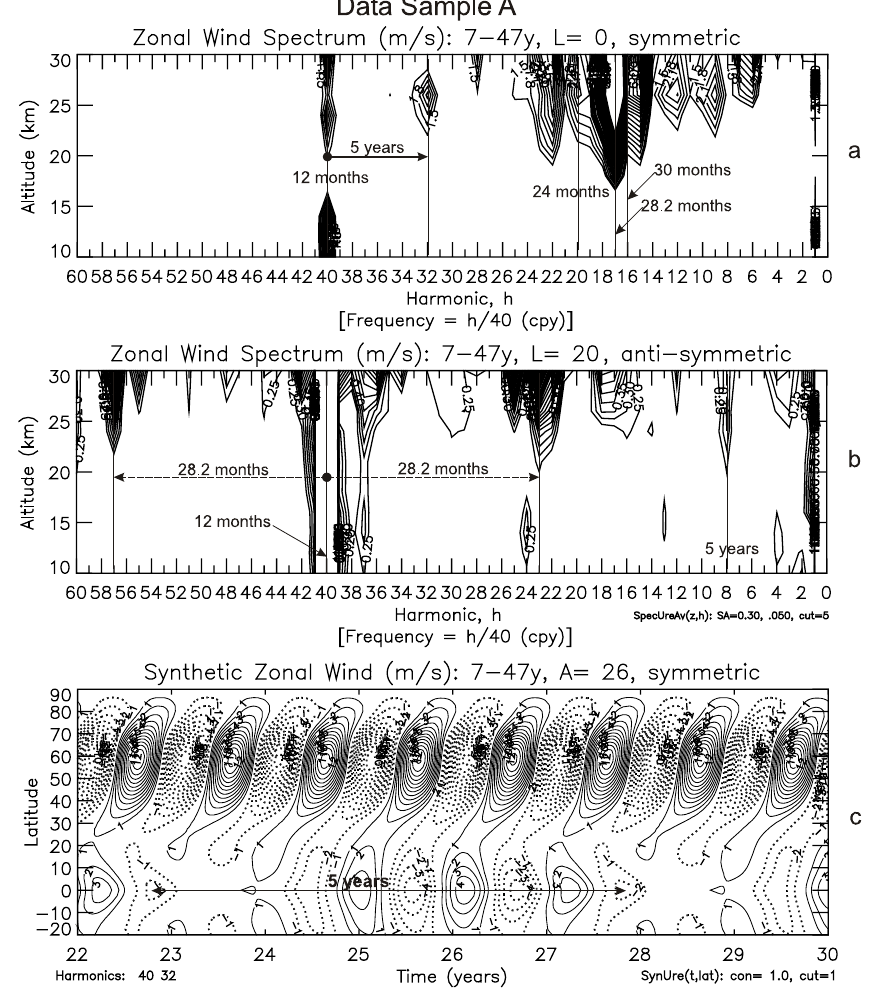
Fig. 1. Sample A (defined in Fig. 2b) of R-1 zonal wind data. Zonal-mean zonal winds are analyzed. The data were selected for a limited time span of 40 years (i.e., 7 to 47 data years). (a) The amplitude spectrum is obtained from Fourier analysis and shows the hemispherically symmetric component at 0 degrees latitude (L=0), virtually identical at 5 degrees. Plotted versus Fourier harmonics, h, the corresponding frequencies for the 40-year time span analyzed are given by h/40 in cycles per year (cpy), and the periods by 40/h (years). [With contour intervals of 0.3m/s, the lowest 4 levels are suppressed to eliminate clutter.] At h=40 is the signature of the 12-month annual oscillation (AO), h=20 and 16 represent the 24- and 30-month QBO signatures, and the dominant QBO period of about 28.2 month appears at h=17. Displaced by h=8 from h=40, at h=32, is the signature of the 5-year modulation of the AO, as indicated with solid arrow and discussed in the main text. (b) Spectrum of hemispherically anti-symmetric component at 20 degrees latitude (L=20) reveals the weak 5-year signature with small contour intervals of 0.05m/s. (c) Synthesized winds at 26km (A=26) employing the symmetric spectral features at h=40, 32. The synthesis represents the 40-year average; thus the patterns repeat exactly in 5-year intervals over the entire time span (7 to 47 years) of the analysis.